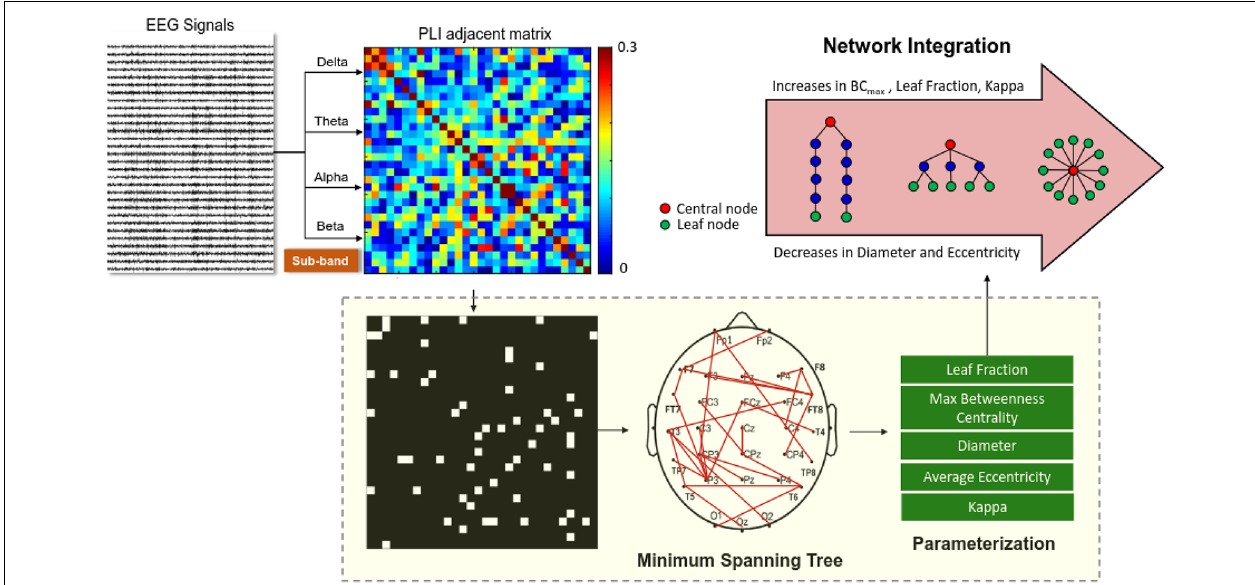
FIGURE 2 | Schematic representation of network integration using variables of EEG-based minimum spanning trees (MSTs). A functional connectivity matrix of the preprocessed sub-band EEG (delta, theta, alpha, or beta rhythms) was constructed using a phase-lag index. MST is a binary backbone graph (edge weights 0 or 1) that includes the strongest connections of the functional connectivity matrix without loops. Five important variables (leaf fraction, maximal betweenness centrality (BC max ), diameter, average eccentricity, and kappa) were selected from the MSTs to index brain network properties.